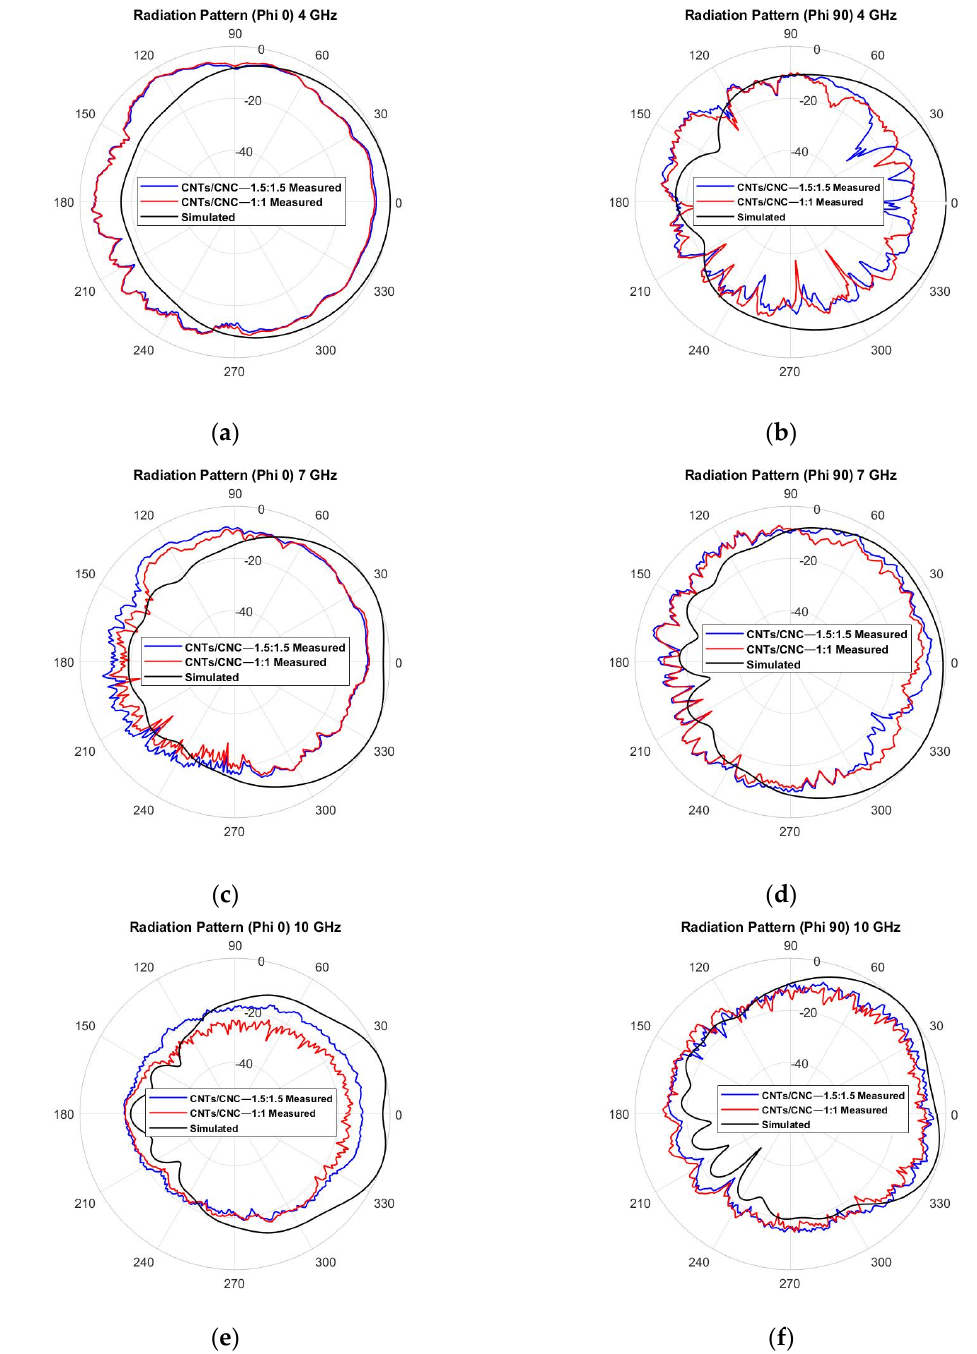
Figure 17. Measured vs. simulated radiation pattern of the graphene-based textile PICA antenna on the phantom, E -plane cut at φ = 90° and H -plane cut at φ = 0°, for the three main frequencies: ( a , b ) 4 GHz; ( c , d ) 7 GHz; ( e , f ) 10 GHz.